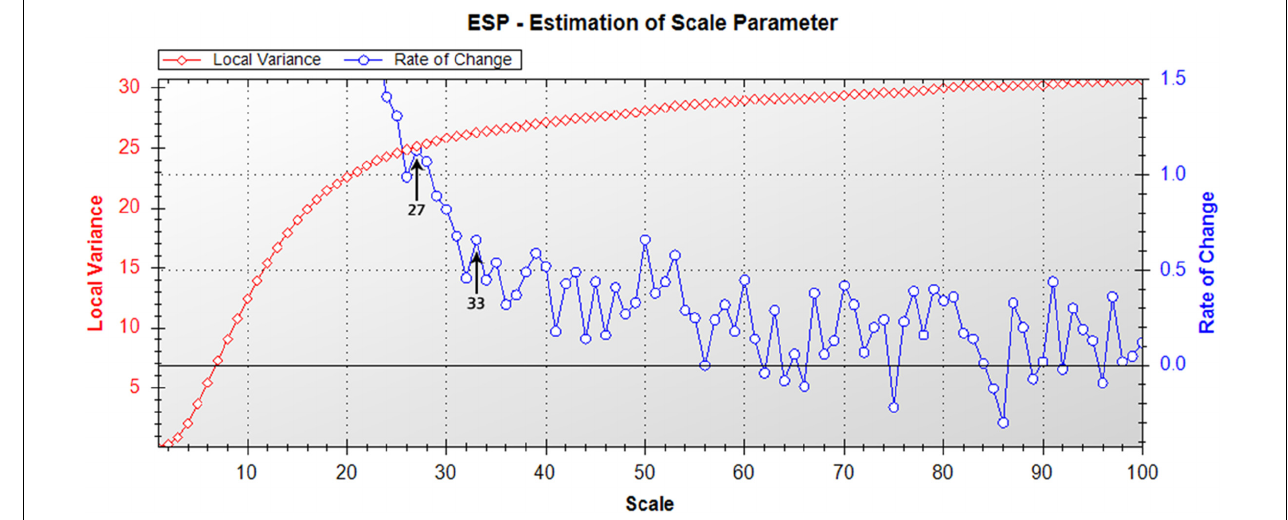
FIGURE 2 | Estimation of scale parameter tool output (Drˇagu¸t et al., 2010) for the nine quadrat image mosaic. Graph depicts changes in local variance (LV, red) and rate of change (ROC, blue) with increasing scale parameter for segmentation of the moss quadrat test mosaic. Peaks in the ROC-LV graph indicate the most appropriate object levels for segmentation. Suitable scales for image segmentation for the mosaic were 27 or 33, as indicated by arrows.